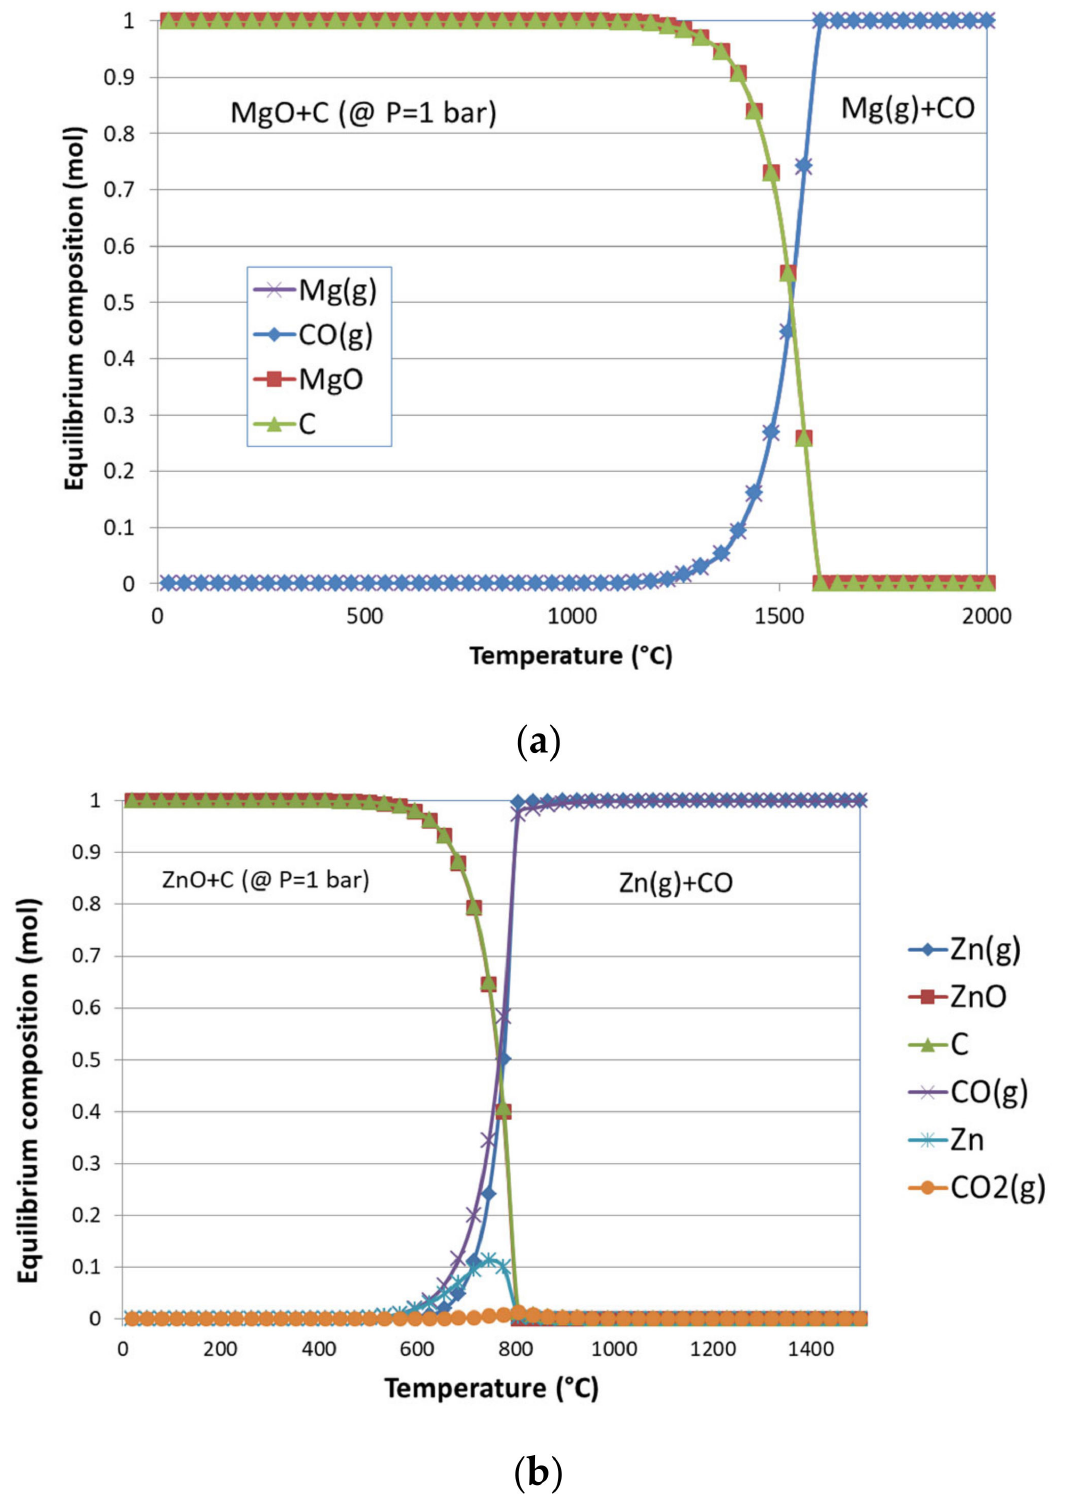
Figure 5. Influence of temperature on equilibrium product distribution for the carbo-thermal reduc- tion of ( a ) MgO and ( b ) ZnO (at P = 1